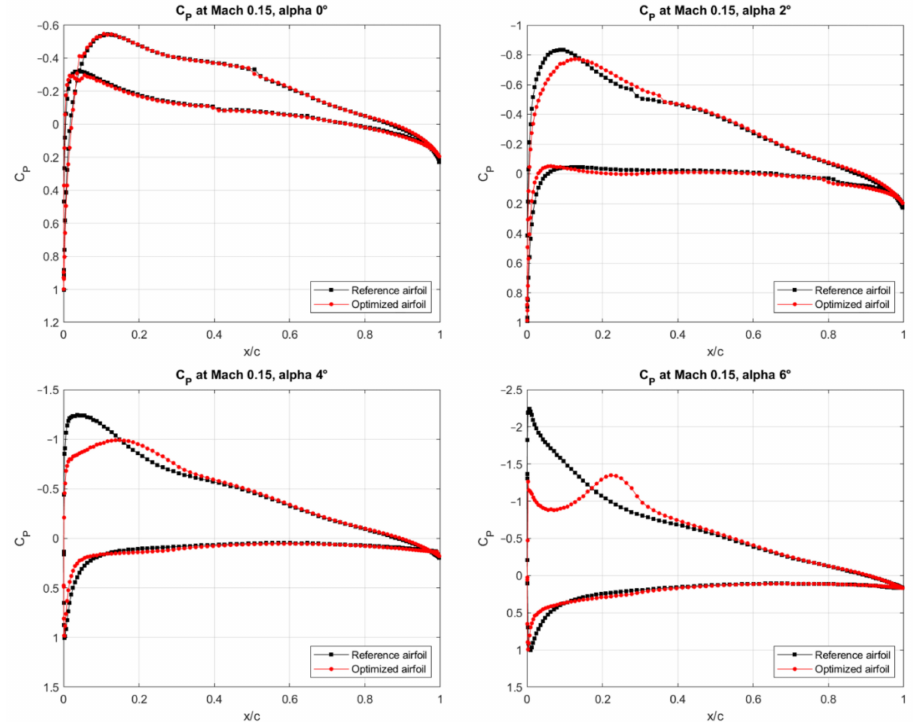
Figure A3. Cp distribution versus the chord obtained for the UAS-S45 optimized airfoil for M =